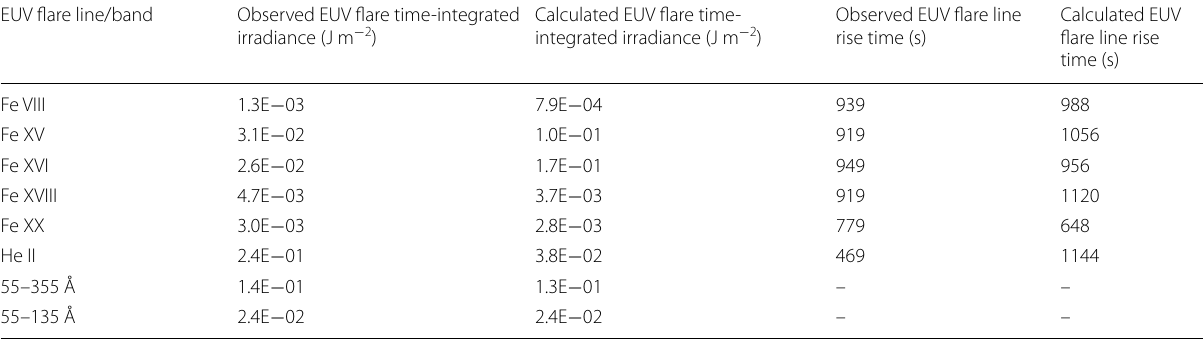
Table 1 Comparative parameters for the M9.9-class flare on January 1,